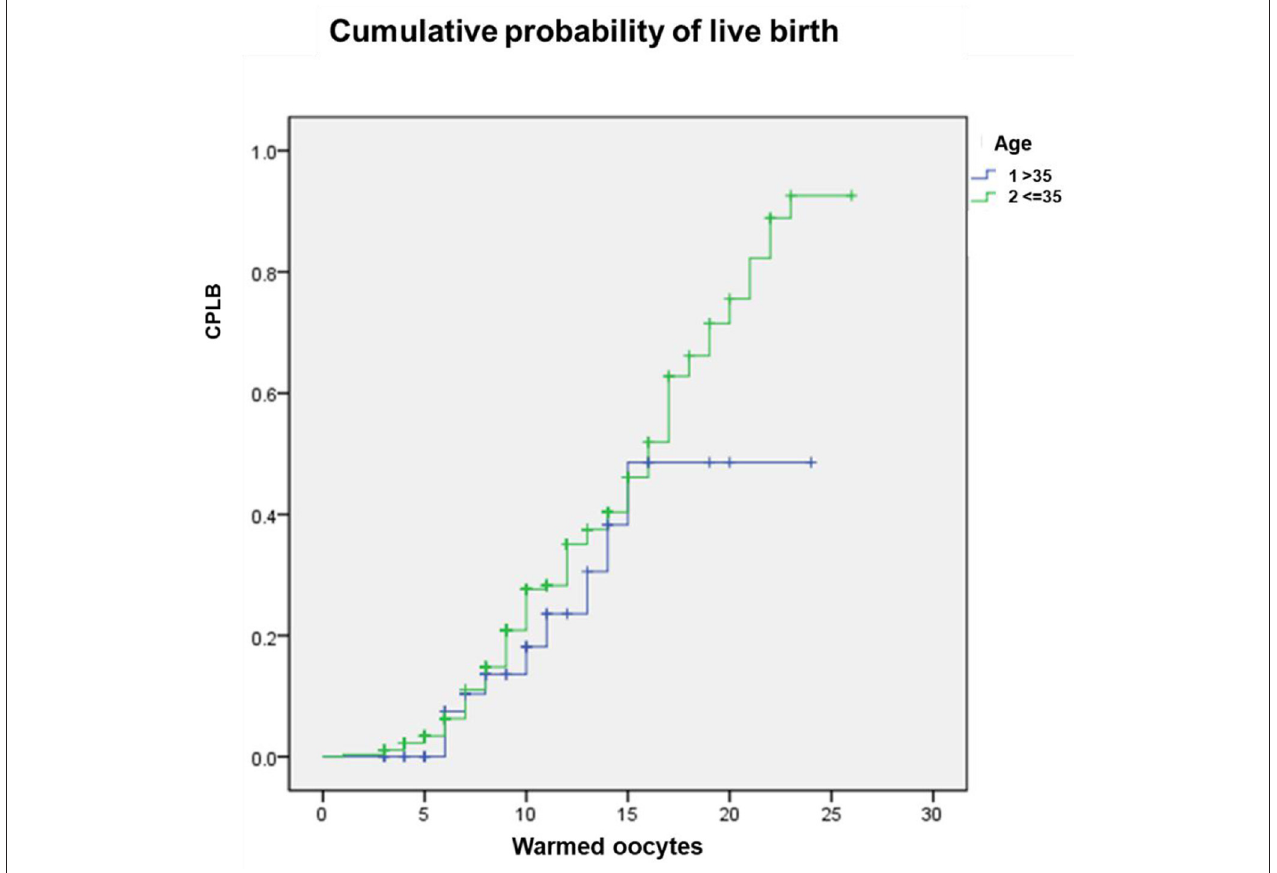
FIGURE 2 | The cumulative probability of live birth according to age ( ≤ 35 vs. > 35 year) and number of oocytes